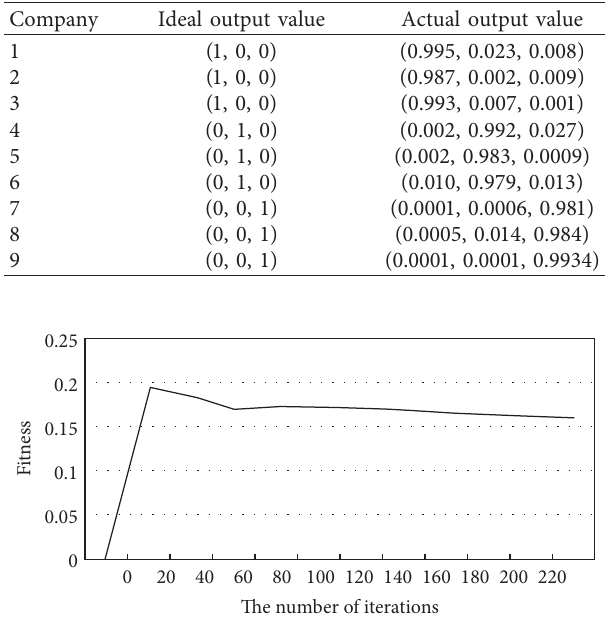
Figure 4: Improved ant colony algorithm optimization objective function convergence